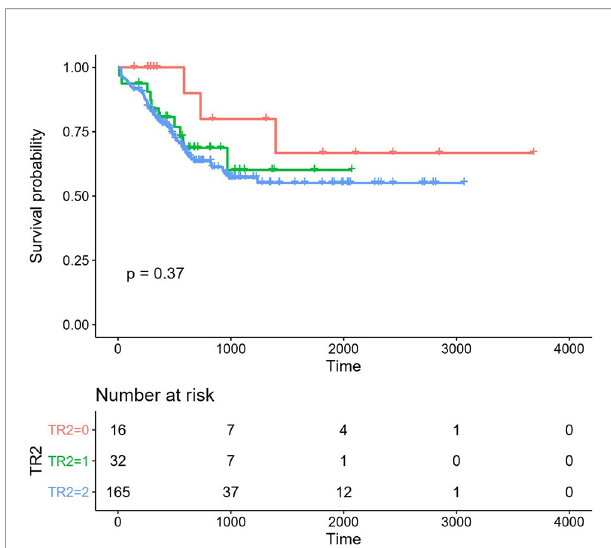
FIGURE 2 | Overall survival (OS) in the different regimen patient groups. Red line: HAA regimen, 3-year OS 80.00% ± 12.65%; Green line: HAA/decitabine regimen, 3-year OS 60.12% ± 11.13%; Blue line: IA regimen, 3-year OS 57.21% ±